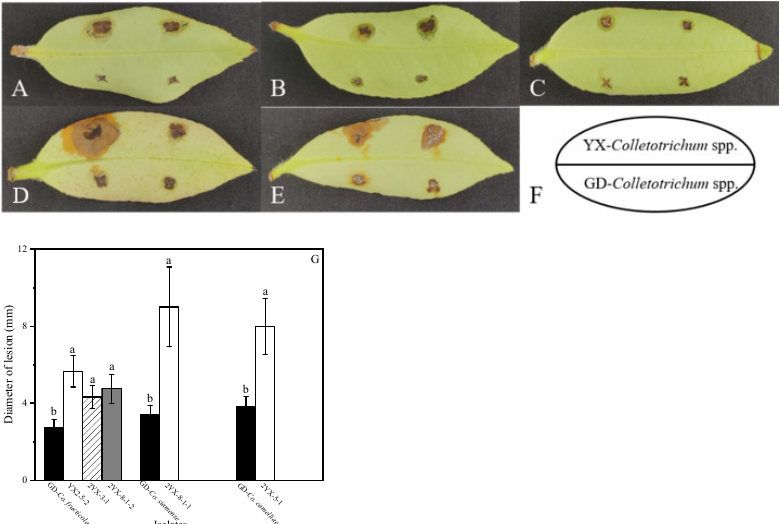
Figure 5. Pathogenicity of GD- Colletotrichum spp. and YX- Colletotrichum spp. on Camellia . oleifera . ( A – C ) Lesion development by YX-Co. fructicola (YX2-5-2, 2YX-3-1, 2YX-8-1-2) and GD-Co. fructicola was photographed at two days post inoculation (dpi); ( D ) Lesion development by YX-Co. siamense (2YX-8-1-1) and GD-Co. siamense were photographed at 2 dpi; ( E ) Lesion development by YX- Co. camelliae (2YX-5-1) and GD- Co . camelliae were photographed at 2 dpi; ( F ) Schematic diagram of pathogenicity. The conidia of GD- Colletotrichum spp. were infiltrated into the underside panel of the leaf, while the YX- Colletotrichum spp. was infiltrated into the upper side panel of the same leaf; ( G ) Lesion diameters were measured at 2 dpi. The error bars represent standard deviations based on six biological replicates. Lesion diameters followed by the same lowercase letter are not significantly different at p < 0.05 using an